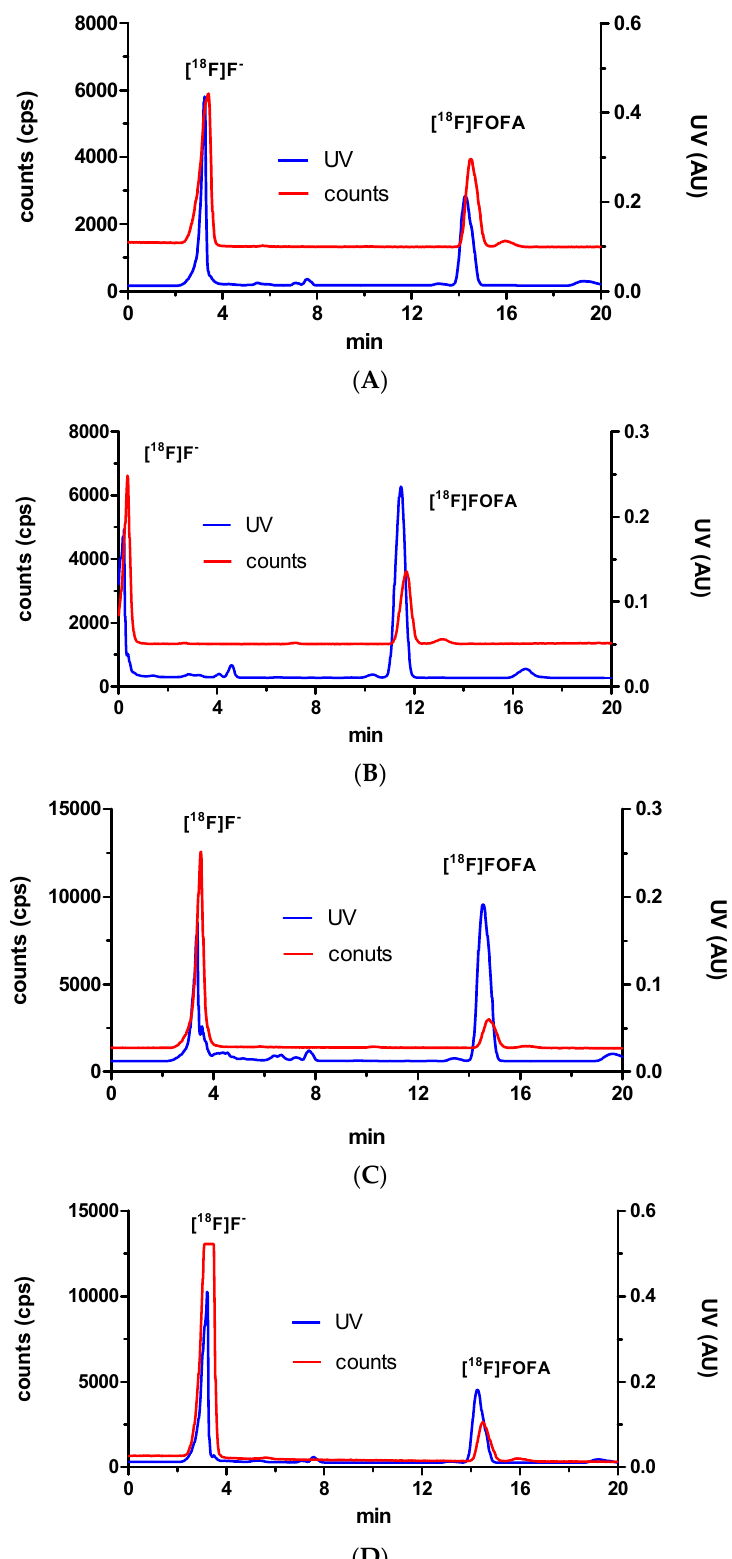
Figure 5. HPLC profiles of the soluble fraction of the [ 18 F]FOFA {[ 18 F]F -1 } mixture in plasma at different times post injection, λ abs = 260 nm. For comparison, a small amount of authentic nonradioactive FOFA 1 was added to the mixture as a referential ultraviolet signal. t R = 3.41 min, [ 18 F]F − ; t R = 14.51 min, [ 18 F]FOFA {[ 18 F]F- 1 }. Samples were taken from mixture after 10 s ( A ); 2 min ( B ); 10 min ( C ) and 30 min ( D ). The time delay of 3 min in the chromatogram ( B ) was denoted due to an unexpected status.